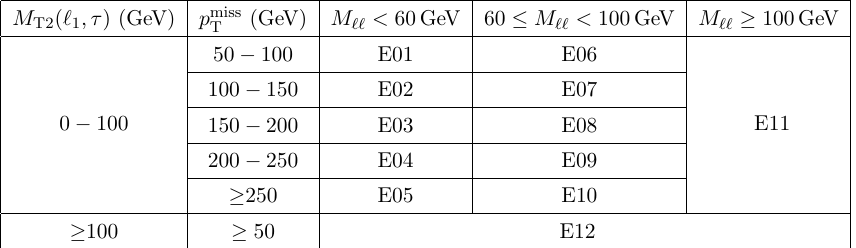
Table 6 . Search region de(cid:12)nition corresponding to category E, events with two e or (cid:22) of same sign and one (cid:28) h candidate.